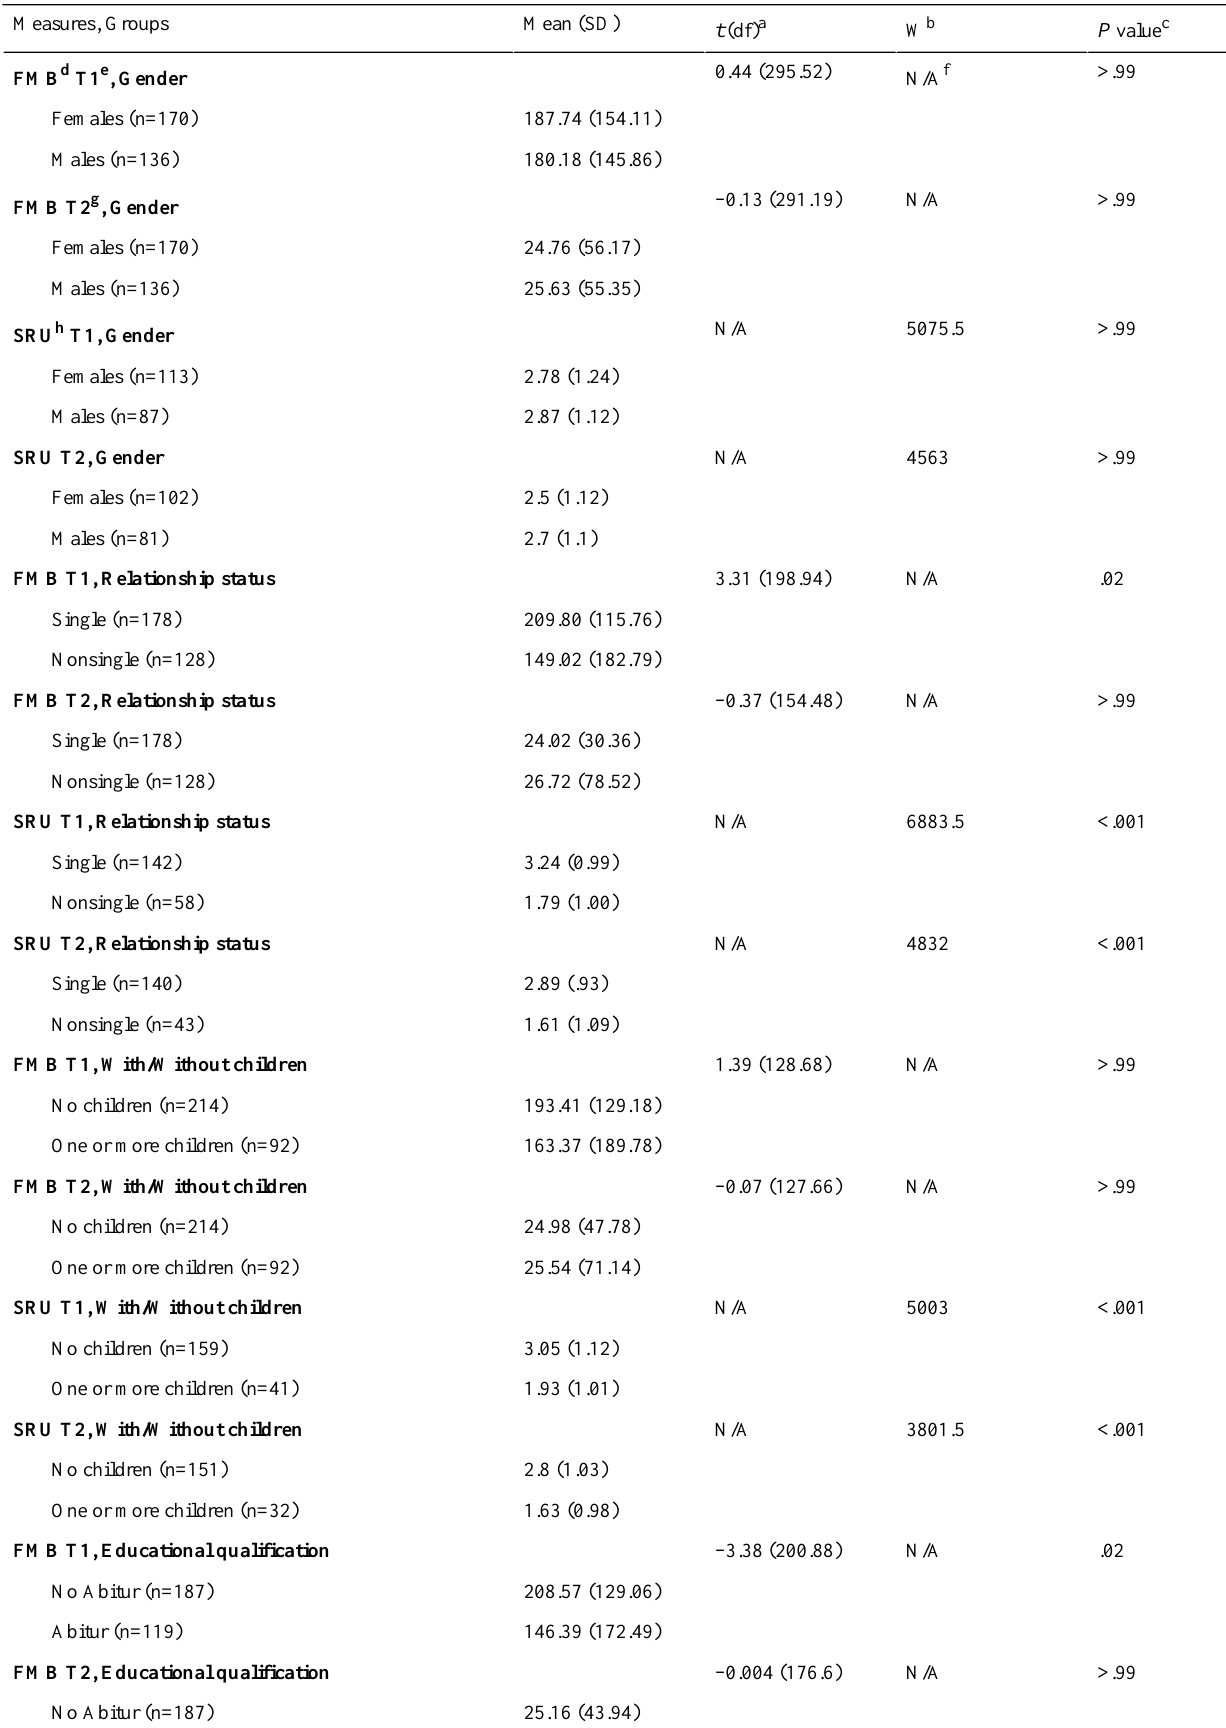
Table 3. Relationships between sociodemographic user characteristics and measures of